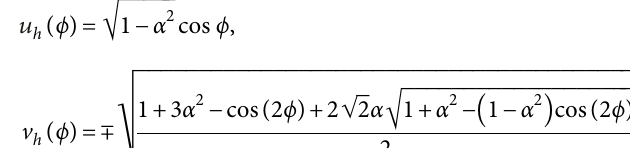
� 1. (a) Potential energy diagram. (b) Phase diagram of the 0